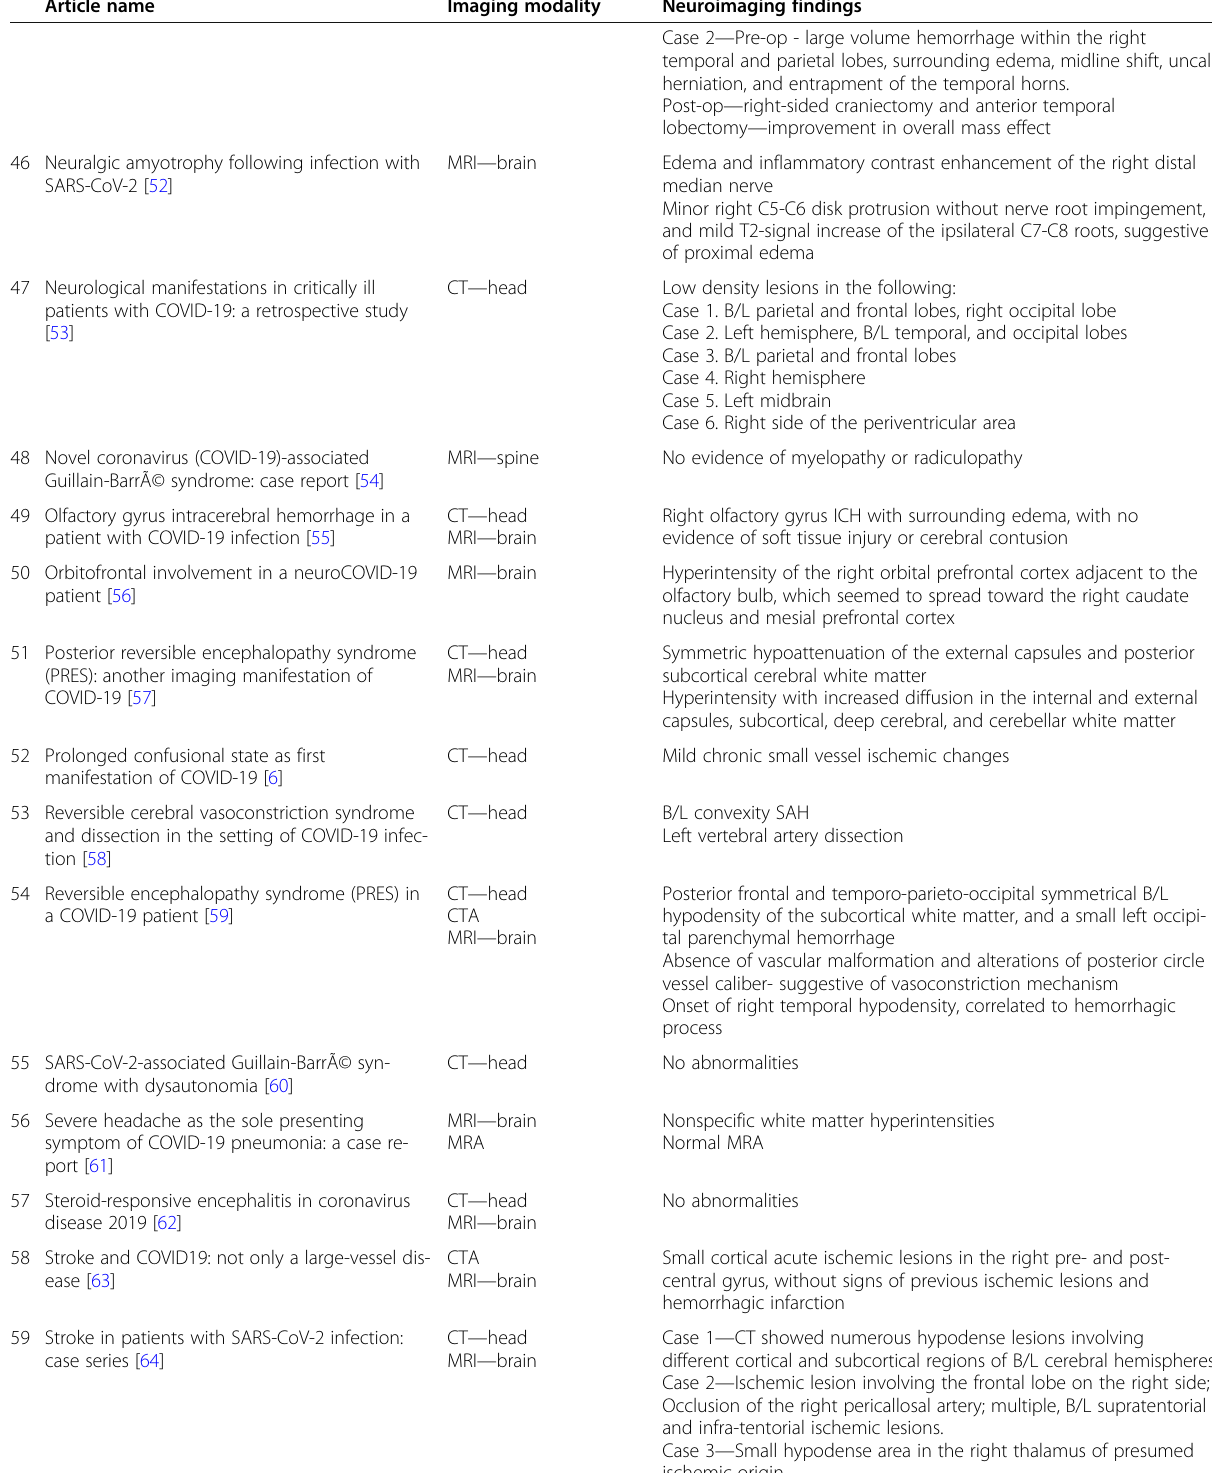
Table 1 Reported studies on COVID-19 patients with neurological manifestations with positive findings on major